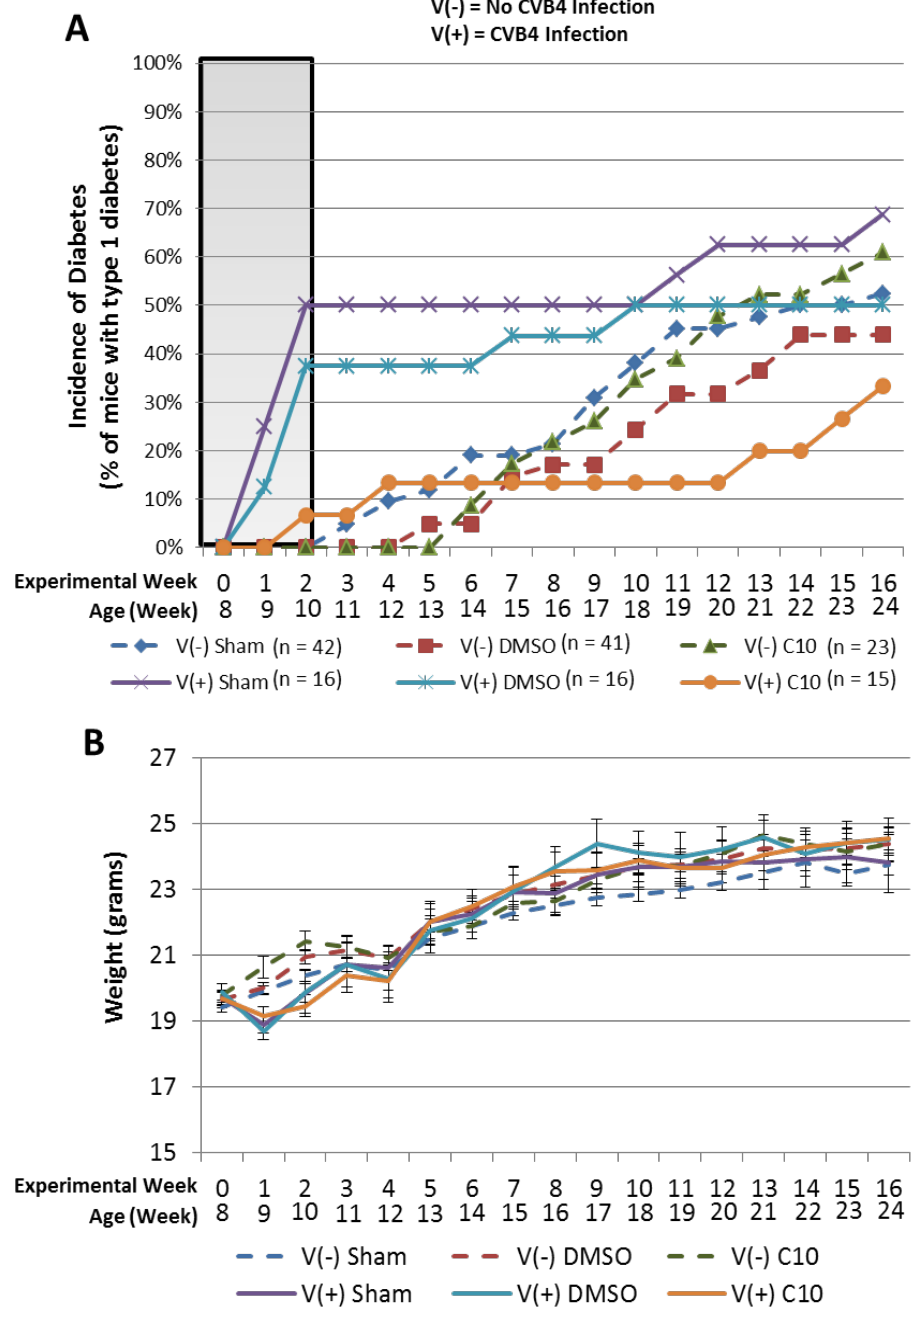
Figure 4. C10 attenuates CVB4 acceleration of type 1 diabetes in NOD mice without toxicity. Eight week old female mice were either infected intraperitoneally with 500,000 pfu of CVB4 or mock infected and/or treated with 1 mg/kg C10, DMSO (solvent control), or sham injection (stress control) as indicated. Incidence of diabetes and weights of mice in each group were recorded weekly. ( A ) Effect of indicated treatment on incidence of diabetes in NOD mice infected with CVB4 (solid lines) or uninfected (dashed lines). ( B ) Effect of indicated treatment on weight of NOD